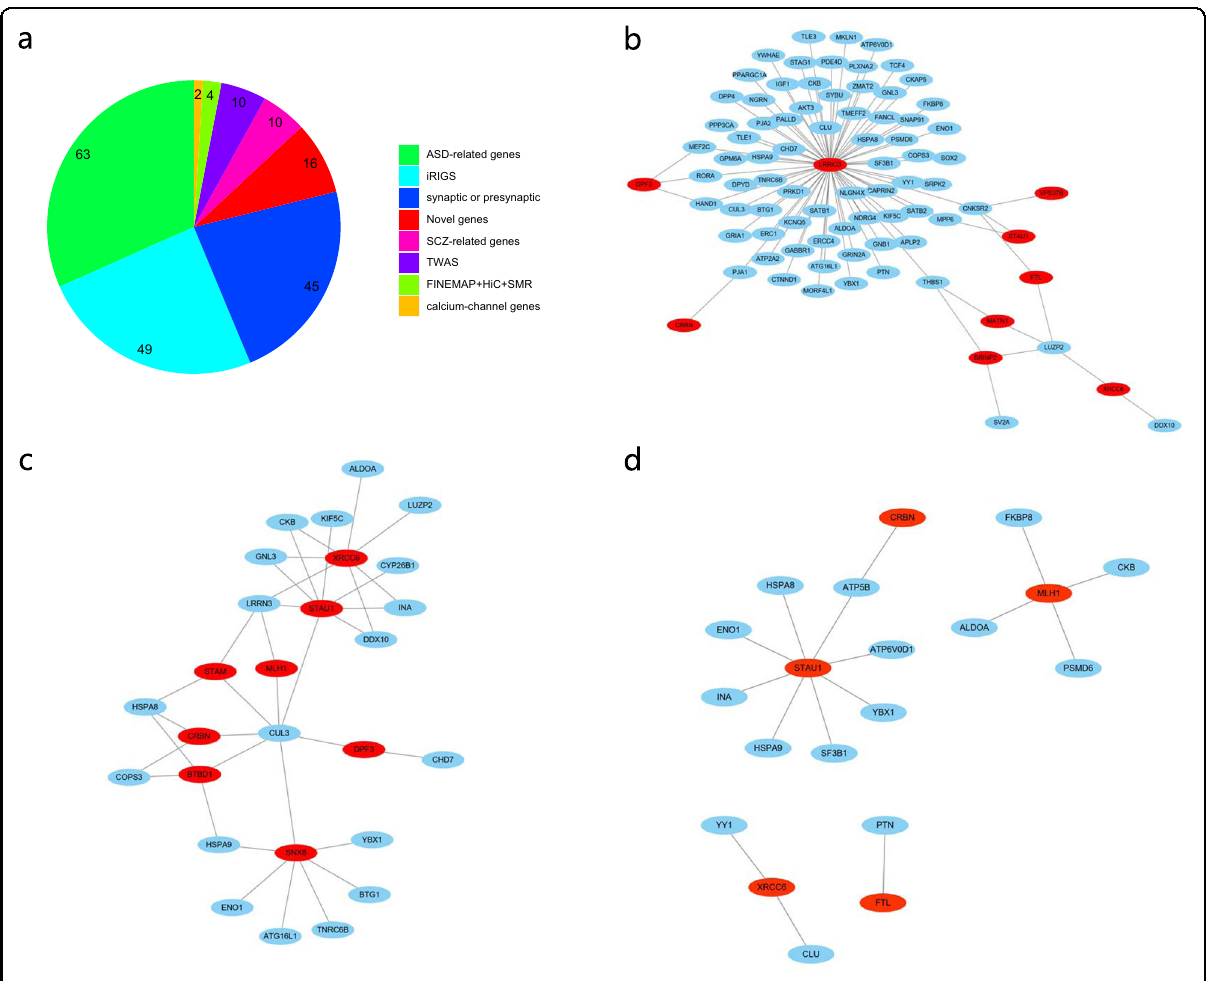
Fig. 5 The HRGs predicted by rGAT-omics exhibited partial overlap with those in other datasets or predicted by other methods. a “ ASD- related gene sets ” represents genes associated with ASD and is from AutDB, ECG, EG, HGM, and HRAR sets (Table S2). In total, 5,138 genes were present in this set, while 63 were predicted to be HRGs by rGAT-omics. “ iRIGS ” represents HRGs predicted by the iRIGS method. In all, 104 HRGs were predicted by iRIGS, which included 49 already predicted by rGAT-omics. “ Synaptic or presynaptic genes ” denotes a set of genes involving synaptic or presynaptic functions, which are from FMRP, PRAZ, PRP, PSD, and SYV datasets as shown in Table S2. In total, 2,803 genes were included in this dataset, which include 45 predicted as the HRGs by rGAT-omics. “ SCZ-related genes ” represent genes from GABA or miR.137.targets gene sets or FUMA (Table S2). In total, 145 genes are included in this dataset, in which ten were predicted as HRGs by rGAT-omics. “ TWAS ” represents a TWAS study for SCZ that identi fi ed 157 SCZ-associated genes, of which ten overlaps with the HRGs predicted by rGAT-omics. “ FINEMAP + HiC + SMR ” represents SCZ causal genes identi fi ed by integrating FINEMAP, chromosome conformation, and SMR analysis. In total, 42 genes were predicted to be SCZ associated and four of them were predicted to be HRGs by rGAT-omics. “ Calcium channel genes ” denotes genes from CCS dataset that include 73 genes. Among them, two were predicted as HRGs by rGAT-omics. “ Novel genes ” represent the HRGs predicted by rGAT-omics but not included in any other datasets or methods. b Red spots denote novel genes and blue spots denote non-novel genes. Nine novel genes interact with the non- novel genes in the GO database. Genes with >30% annotations in common were lined up. c Eight novel genes have >30% interactions shared with the non-novel genes in TissueNet (hippocampus). Genes with >30% interactions in common were lined up. d Five novel genes have 16 interactions with the non-novel genes in the BioGRID